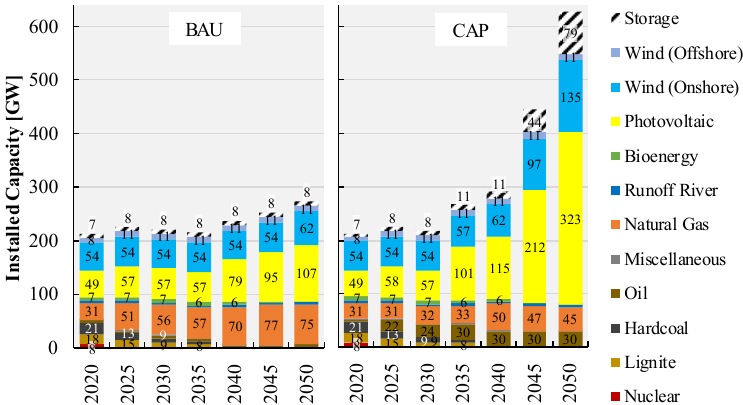
Figure 3. Results of the linear programming of the electricity market model E2M2: Net power production including trade balance in the BAU and CAP scenarios. Values below 3 TWh are not labeled.